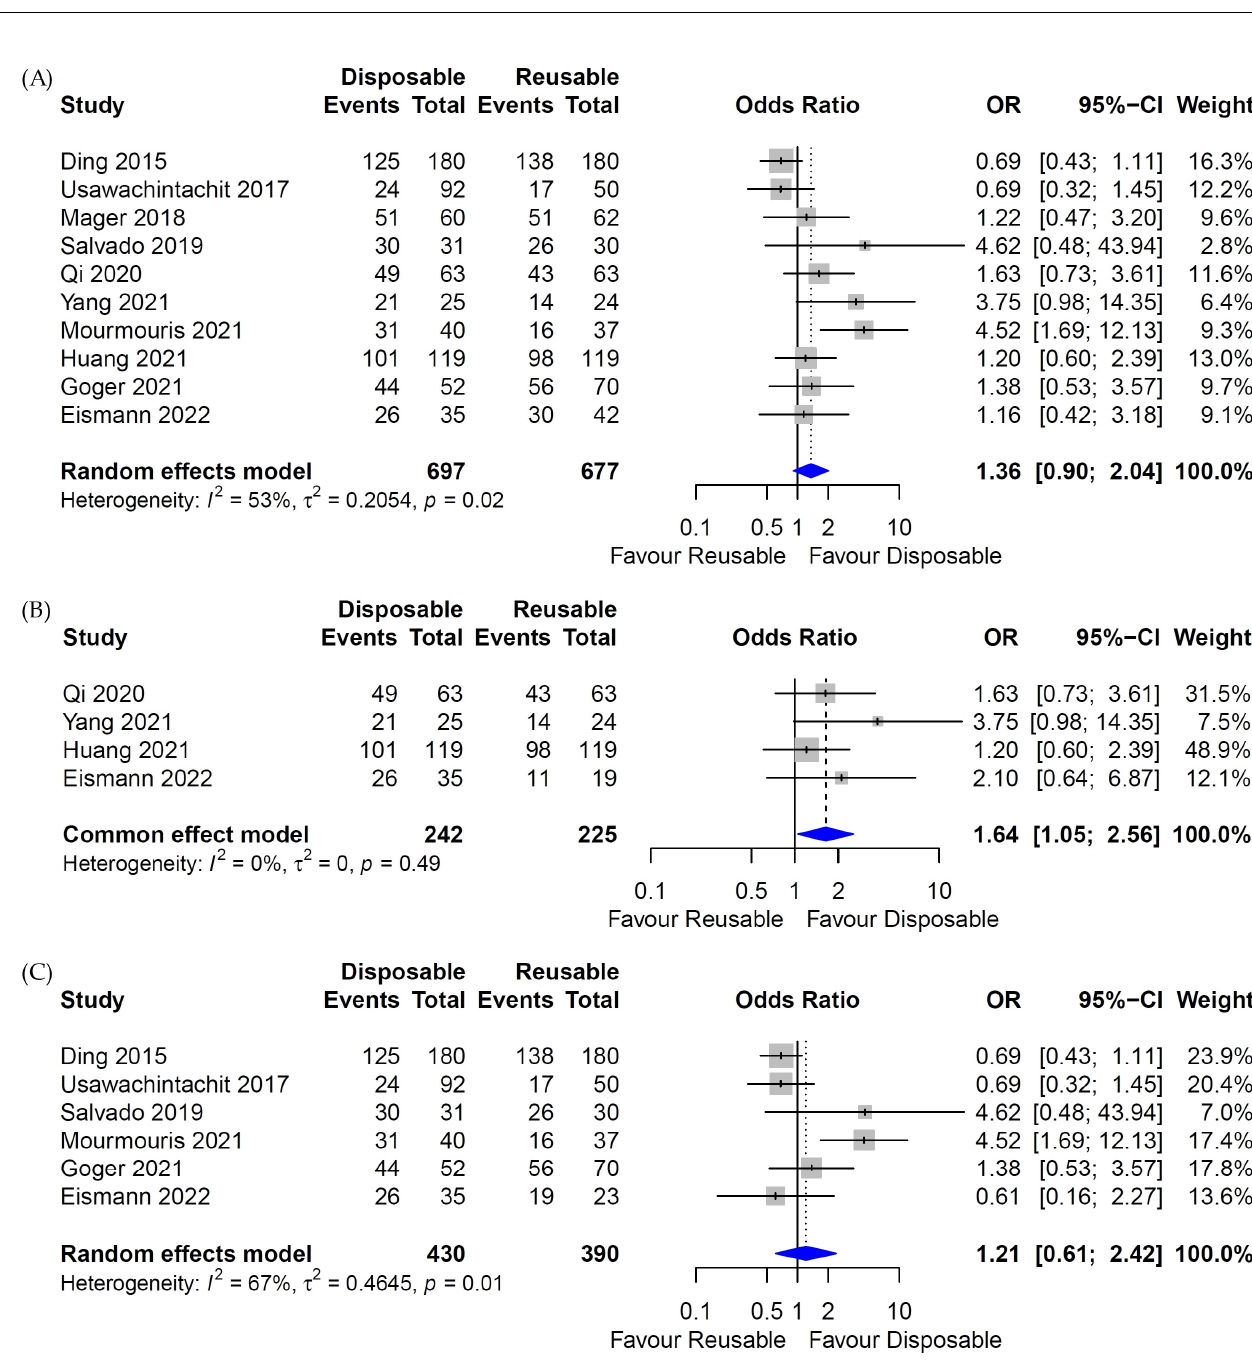
Figure 2. Forest plot for stone-free rate (SFR) between disposable and reusable flexible ureteroscopic stone surgeries (fURS). ( A ) SFR of disposable and whole reusable fURS. ( B ) SFR of disposable and digital reusable fURS. ( C ) SFR of disposable and fiber-optic reusable fURS [17–26].